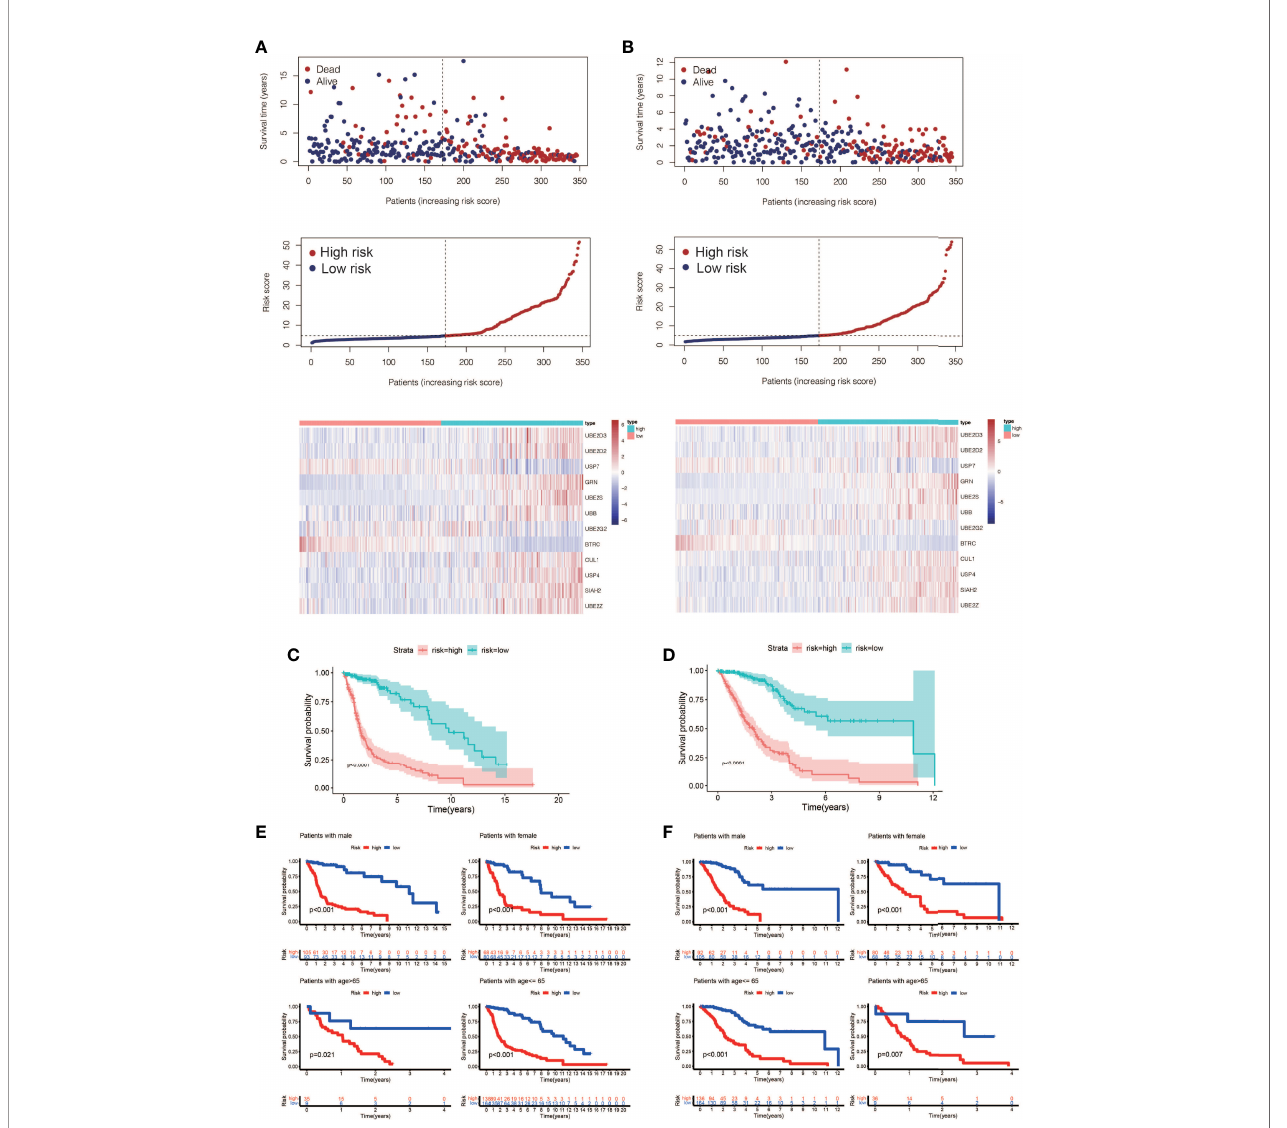
FIGURE 3 | Prognostic model construction and evaluation. (A) The training cohort ’ s survival status, risk score, and model gene expression. (B) The validation cohort ’ s survival status, risk score, and model gene expression. (C) Analysis of the training cohort ’ s survival. The high-risk patients had considerably worse outcomes than the low-risk patients (P < 0.0001). (D) Analysis of the validation cohort ’ s survival. The high-risk patients had considerably worse outcomes than the low-risk patients (P < 0.0001). (E) A training cohort subgroup survival analysis. In different genders and age groups, a high risk score is linked to a poor prognosis. (F) Analysis of subgroup survival in the validation cohort. In different genders and age groups, a high risk score is linked to a poor